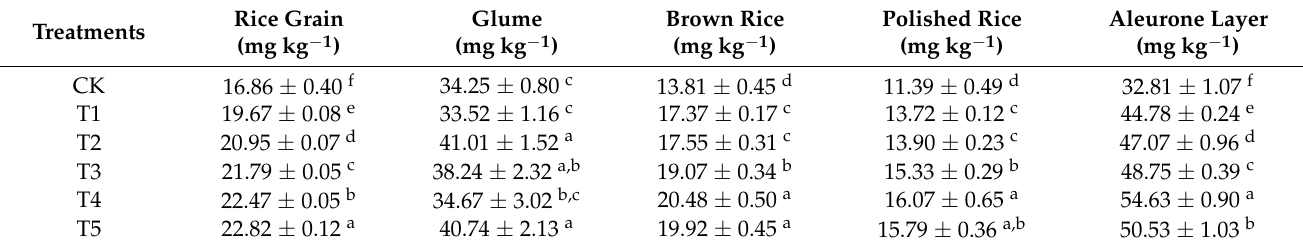
Table 7. Zinc concentration of rice grain, glume and brown rice under different ZnO NPs application amounts.